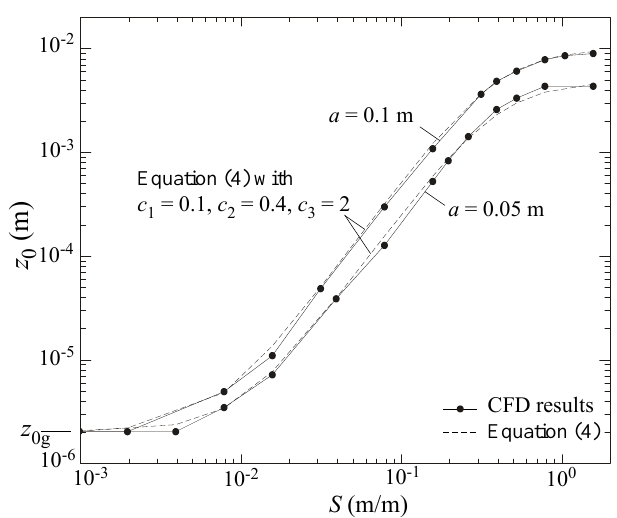
Figure 11. Plot of the z 0 value predicted by the PHOENICS CFD model for flow over sinusoidal terrain with two values of the ampli- tude, a , and a wide range of values of the maximum slope values, S . Also shown are predictions of Eq. (3) for the best-fit parameter